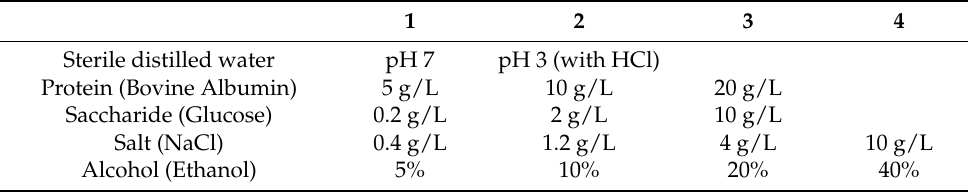
Table 2. Overview of tested model